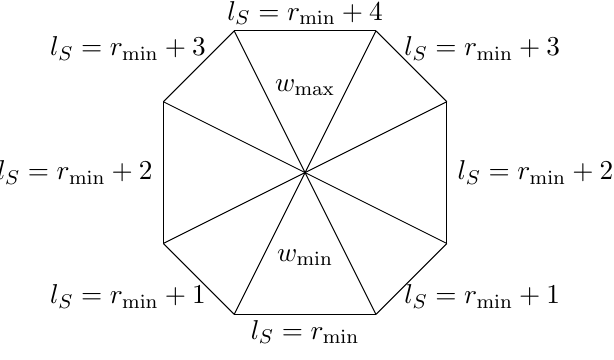
Figure 11 . A cross section view of the polyhedral cells in the tessellation which meet around a common edge, E ab , for m ab =